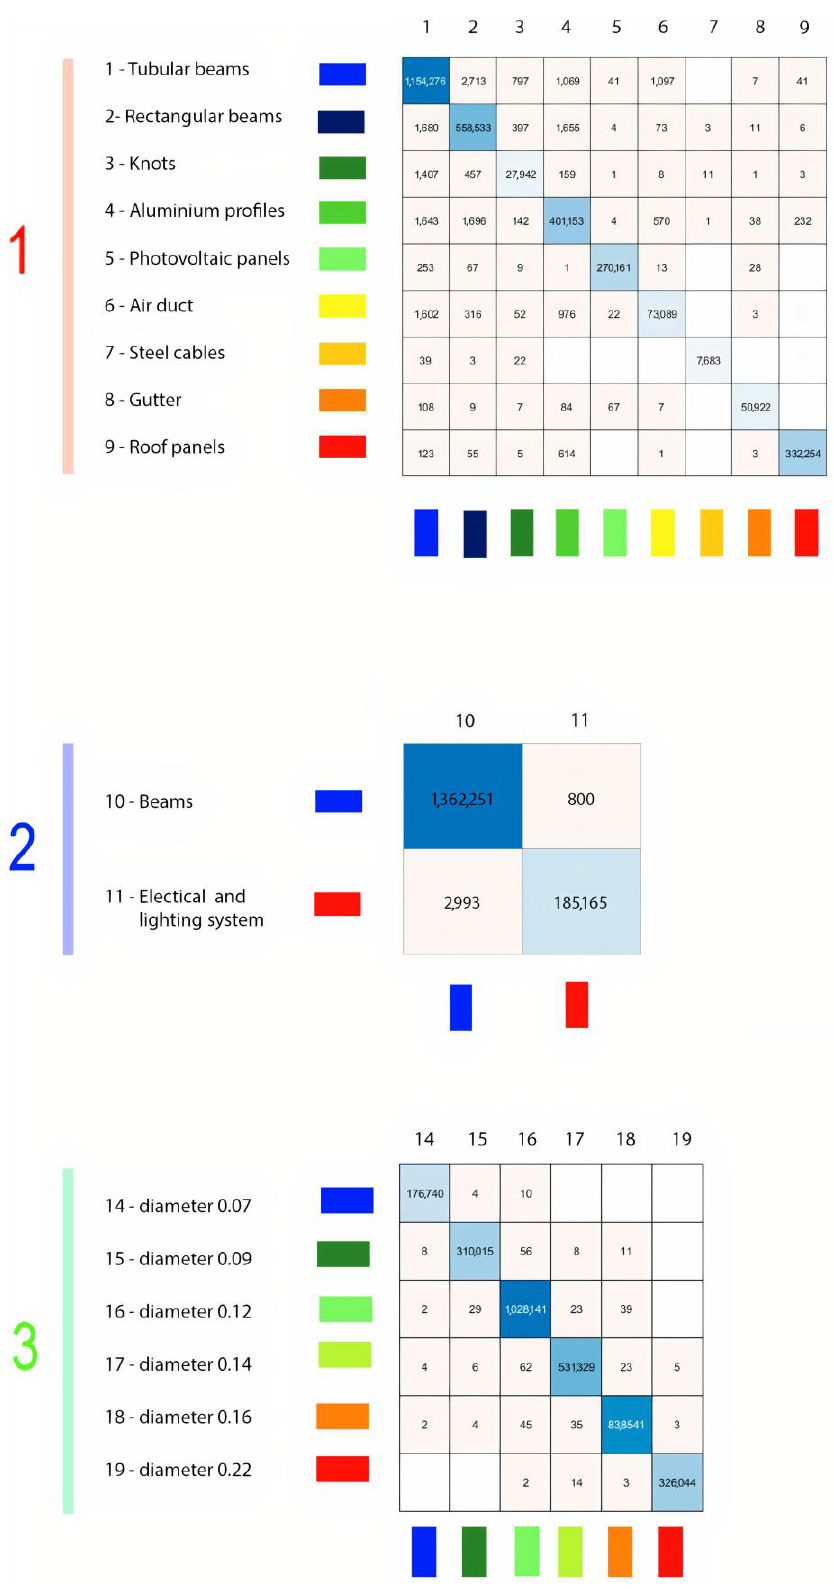
Figure A2. Confusion matrices for the three classification levels.